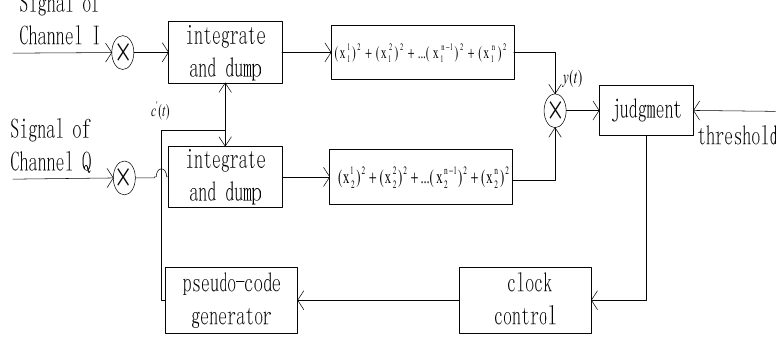
Figure 10. Block diagram of the proposed serial acquisition algorithm.